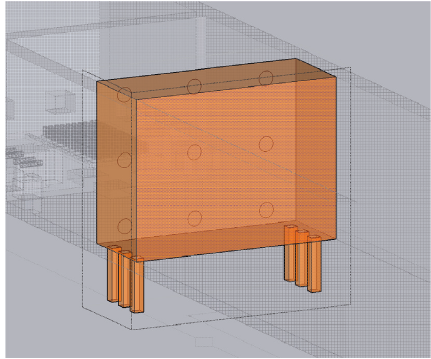
Figure 11: Locations for measuring argon volume fraction (nine